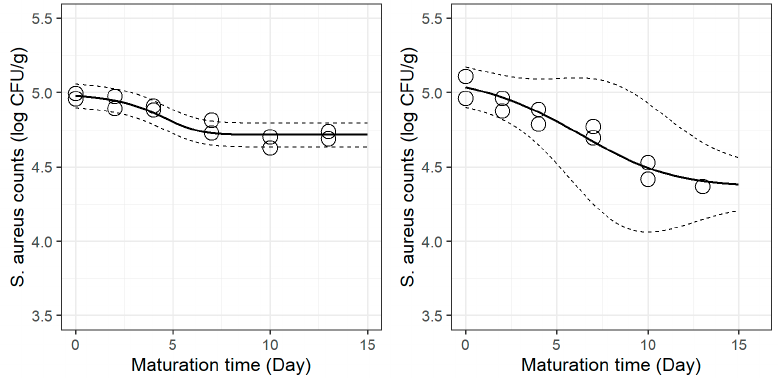
Figure 2. Survival of S. aureus in goat’s raw milk cheese without ( left ) and with ( right ) lemon balm extract, as depicted by dynamic models with 95% confidence intervals (dotted